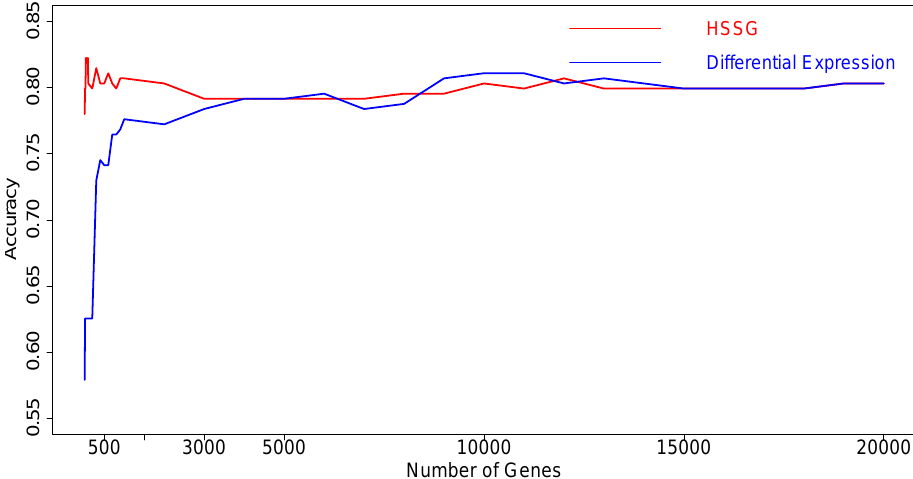
Figure 11. The changing cluster accuracy curve for two different ways to add